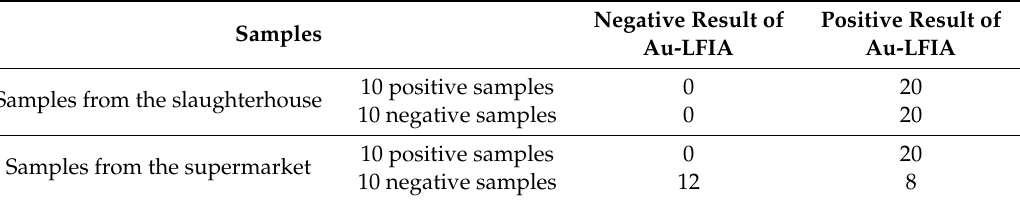
Negative Result of Positive Result of Au-LFIA Au-LFIA